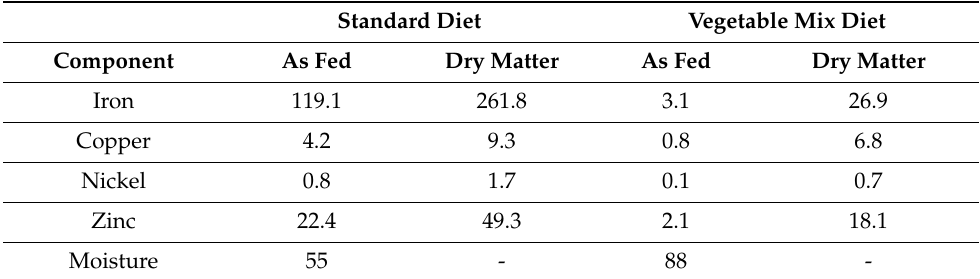
Table 2. Heavy metal content of the two experimental diets. Values are expressed as mg per Kg of diet. Standard Diet Vegetable Mix Diet Component